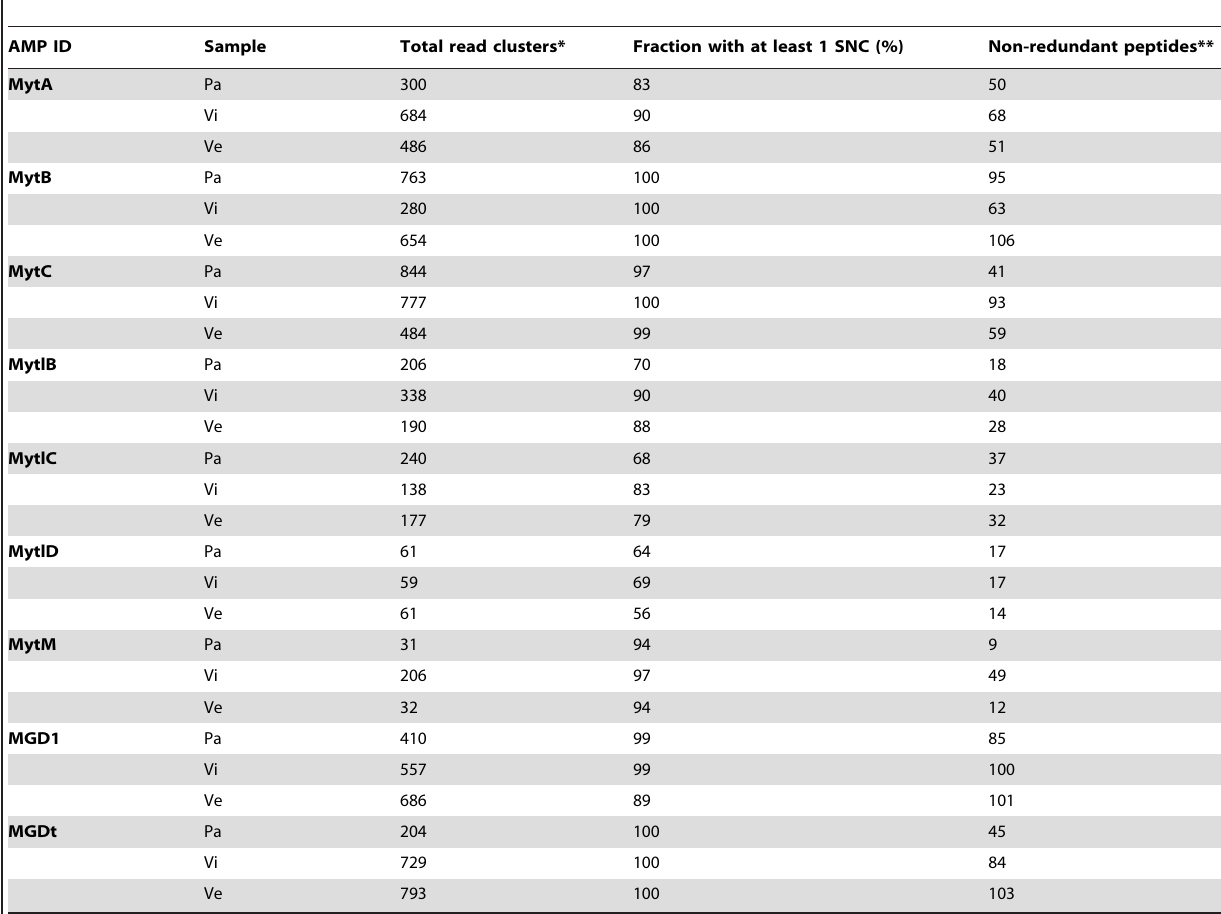
Table 4. AMP transcript variants and expected number of non-redundant peptides per geographical